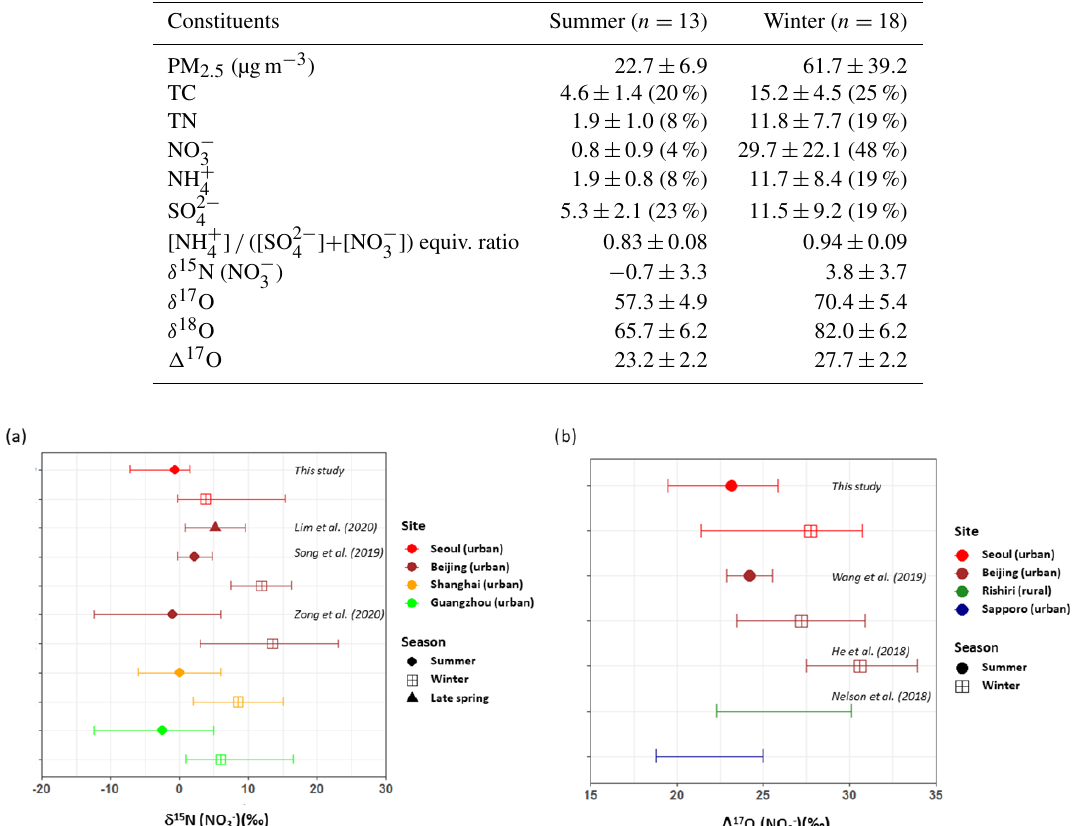
− ) and (b) (cid:49) 17 O (NO − ) PM 2 . 5 observed in northeast Asia are compared: Seoul in this study (red); Beijing (brown), Figure 2. (a) δ 15 N (NO 3 3 Shanghai (orange), and Guangzhou (light) in China; and Rishiri (green) and Sapporo (blue) in Japan during summer (circle) and win- ter (square). Annual ranges were presented for Rishiri and Sapporo. Marker indicates mean value (concentration-weighted average for Seoul samples of the present study), and lower and upper whiskers denote minimum and maximum values (this study; He et al., 2018; Lim et al., 2020; Nelson et al., 2018), mean ± SD (Song et al., 2019; Wang et al., 2019b), or 25th and 75th percentiles (Zong et al., 2020). Different marker shapes indicate different